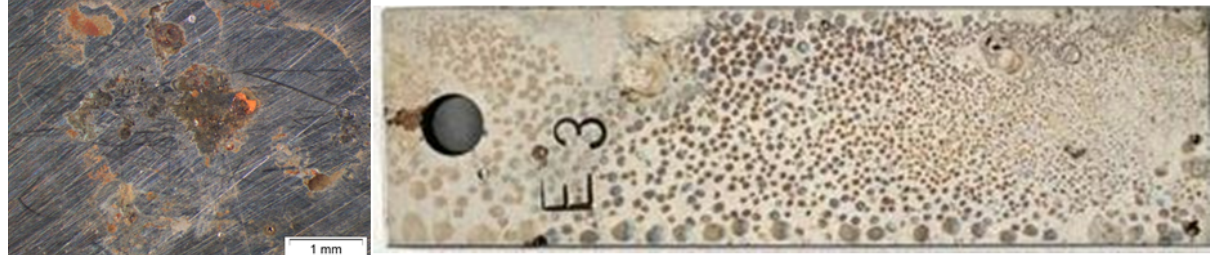
Figure 1. Left: SEM micrographs (8000 h at 60 °C/100 bar exposed to water-saturated supercritical CO 2 ) of the corrosion layer formed on X5CrNiCuNb16-4 with ellipsoidal peculiarity on hardened and tempered at 670 °C. Reprintetd with permission from [16]. 2021 MDPI, A. Pfennig.